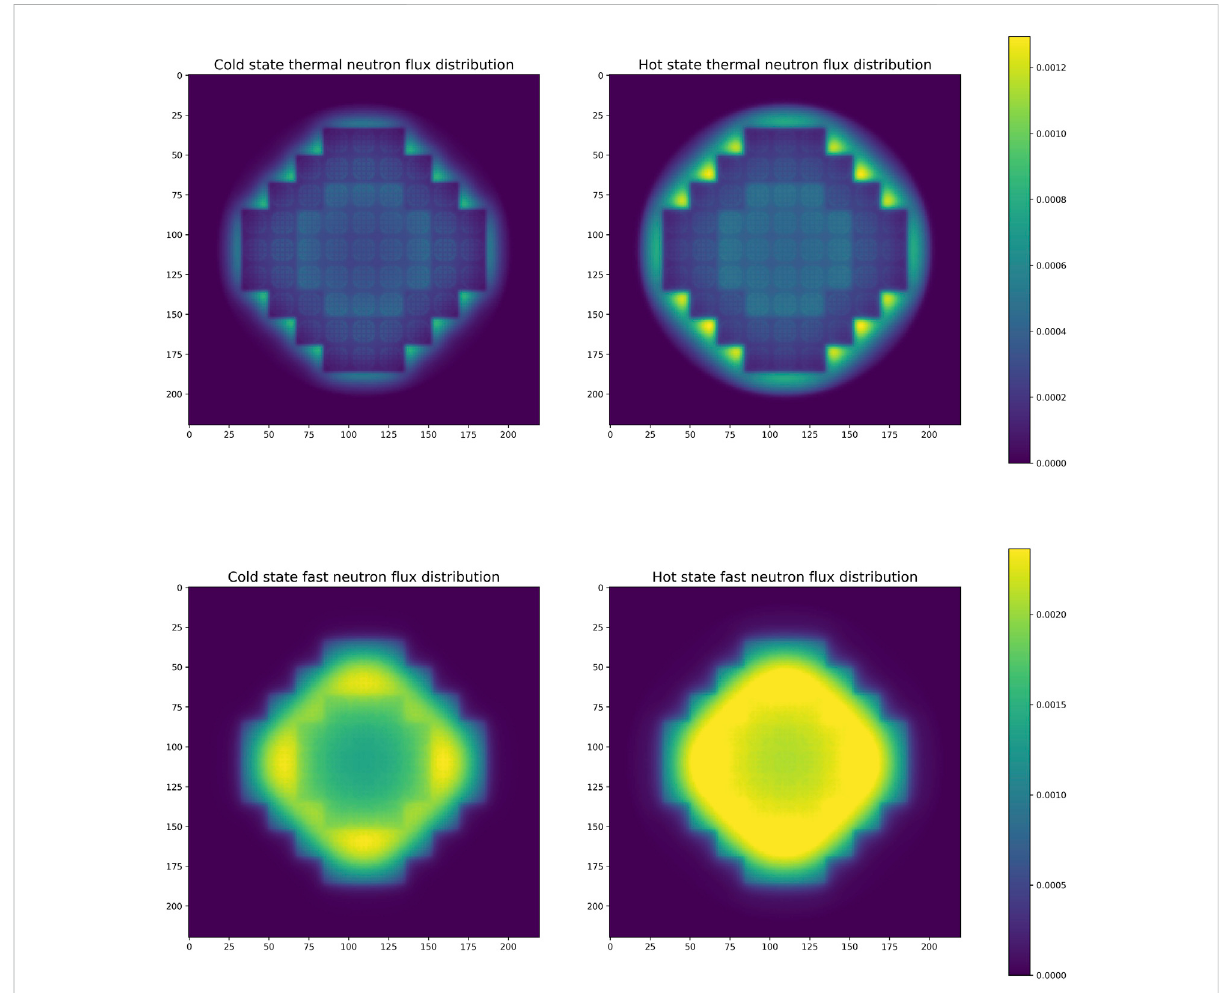
FIGURE 5 The thermal and fast neutron fl ux distributions in the two-batch refuelling scheme